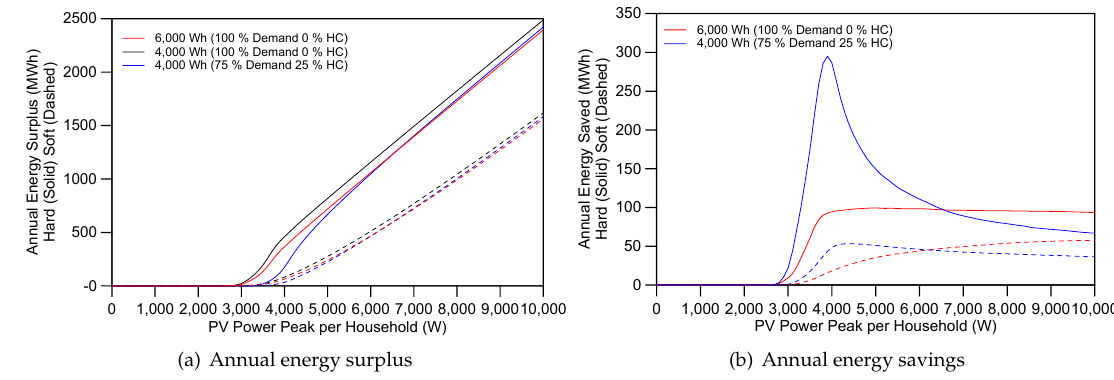
Figure 14. Annual energy surplus and energy saved for a cluster of 200 households when soft curtailment (dashed lines) or hard curtailment (solid lines) is